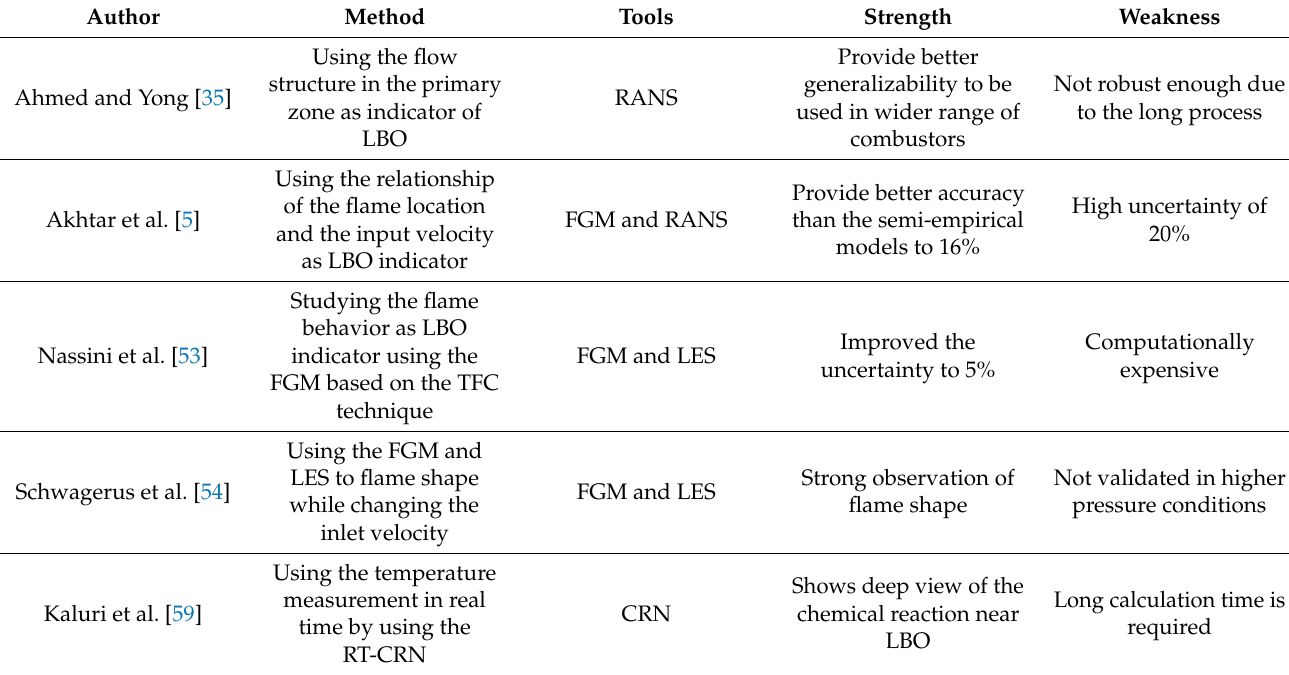
Table 2. Numerical simulation